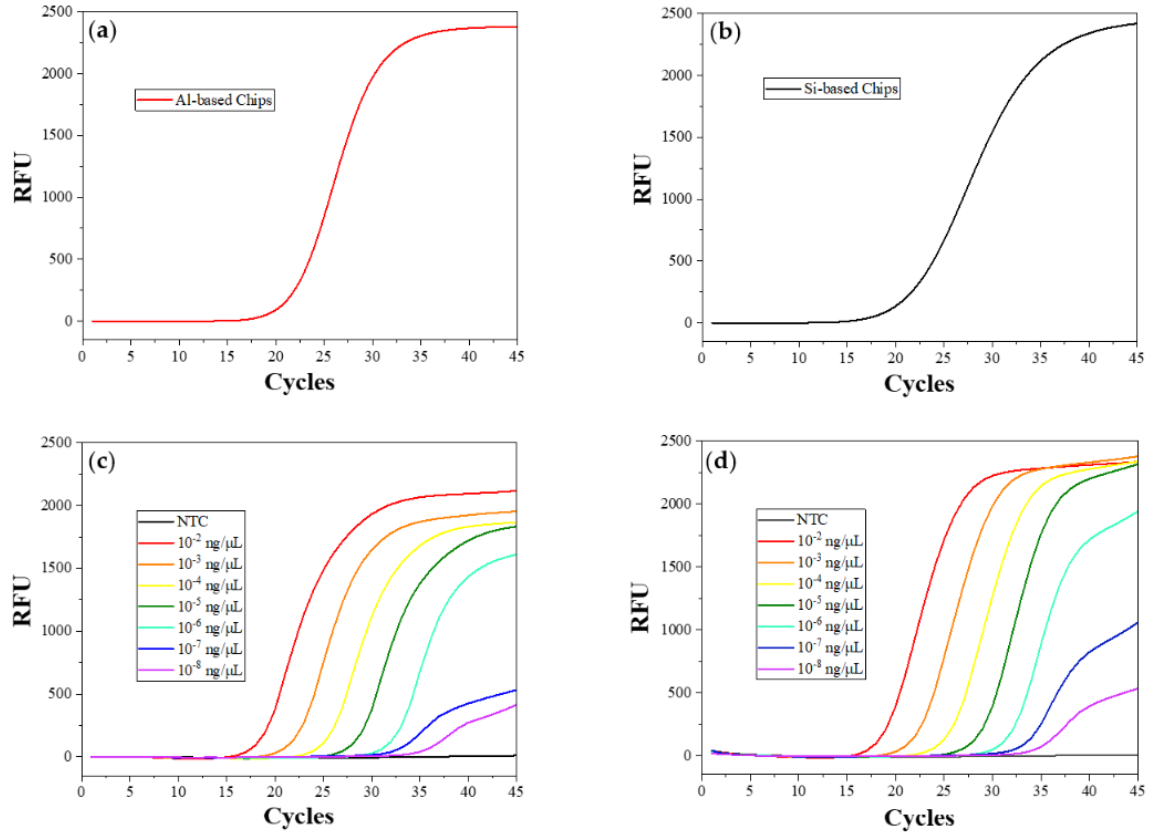
Figure 5. Amplification result of ( a ) the real-time PCR test in the aluminum-based chip, ( b ) the real-time PCR test in the silicon-based chip (Control A), ( c ) the real-time PCR tests in the aluminum-based chips testing 10 − 2 ng/reaction (about 2.5 × 10 6 copies) to 10 − 8 ng/reaction (about 2 copies); ( d ) the real-time PCR tests in traditional polypropylene tubes (Control B) testing 10 − 2 ng/reaction (about 2.5 × 10 6 copies) to 10 − 8 ng/reaction (about 2 copies).